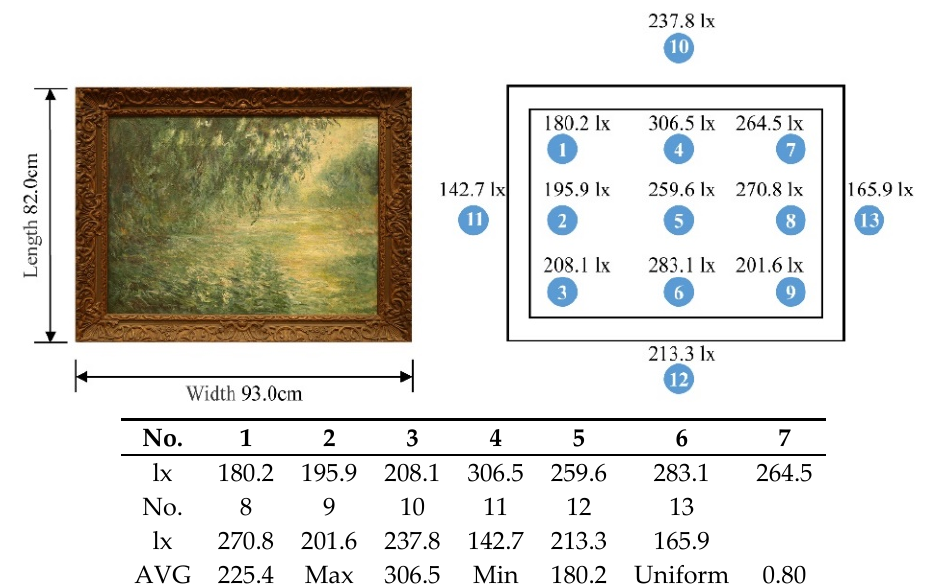
Figure 6. Illumination distribution test of oil painting and background wall in indirect lighting environment.